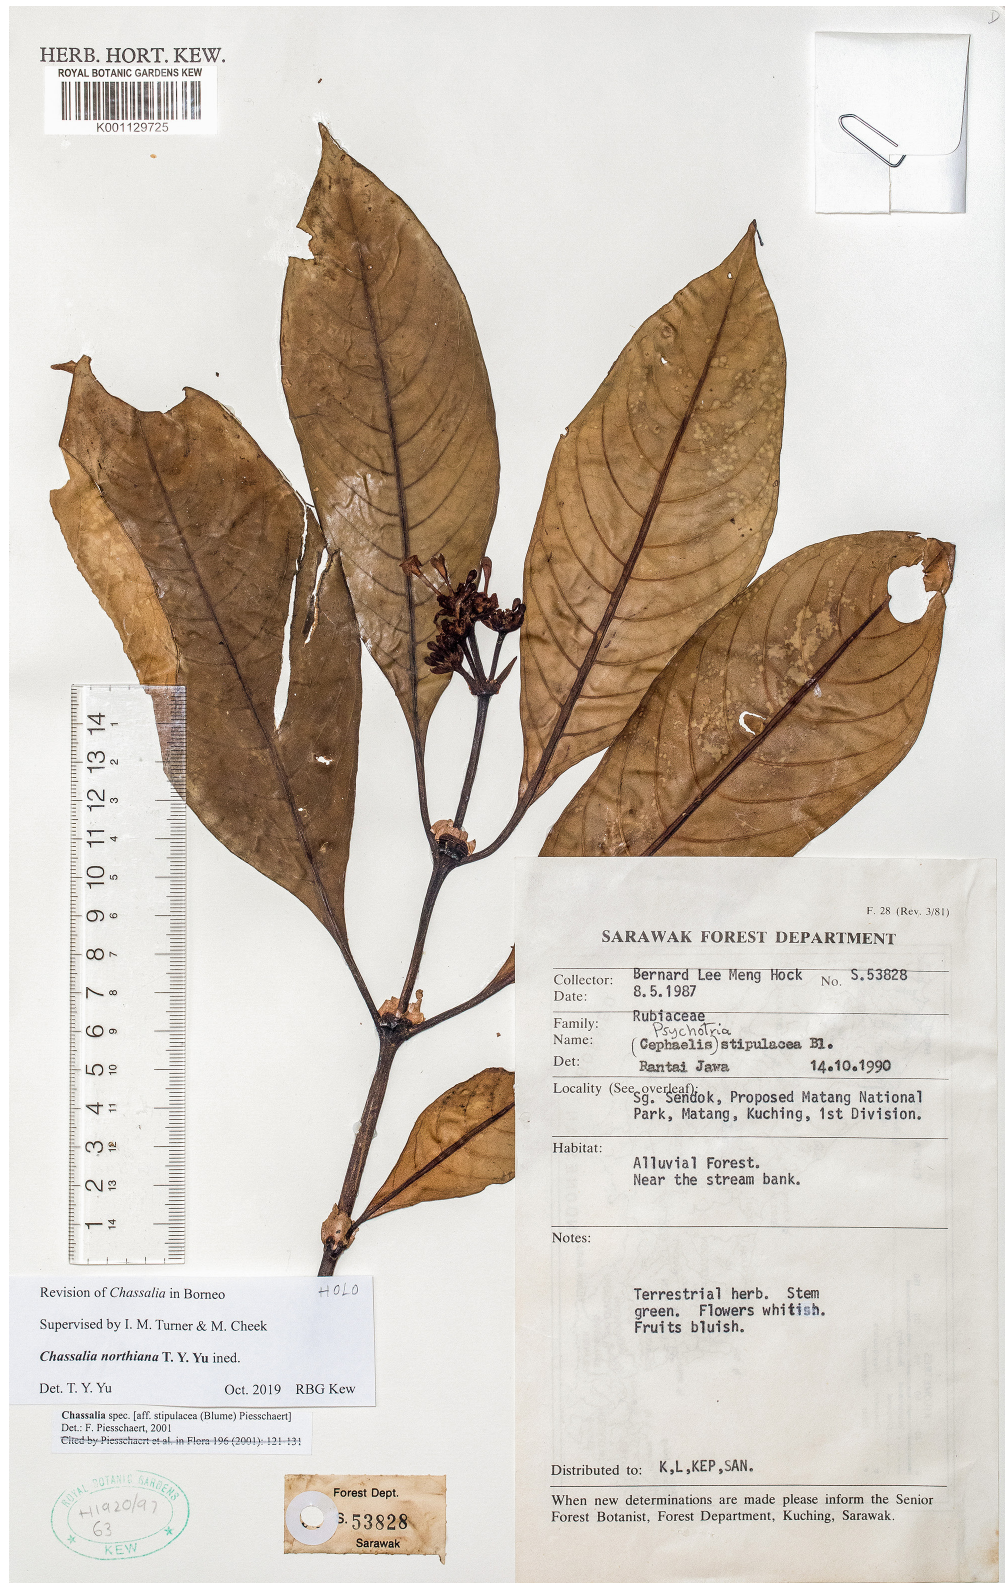
Fig. 29. Holotype of Chassalia northiana T.Y.Yu sp. nov. ( Bernard Lee Meng Hock S 53828